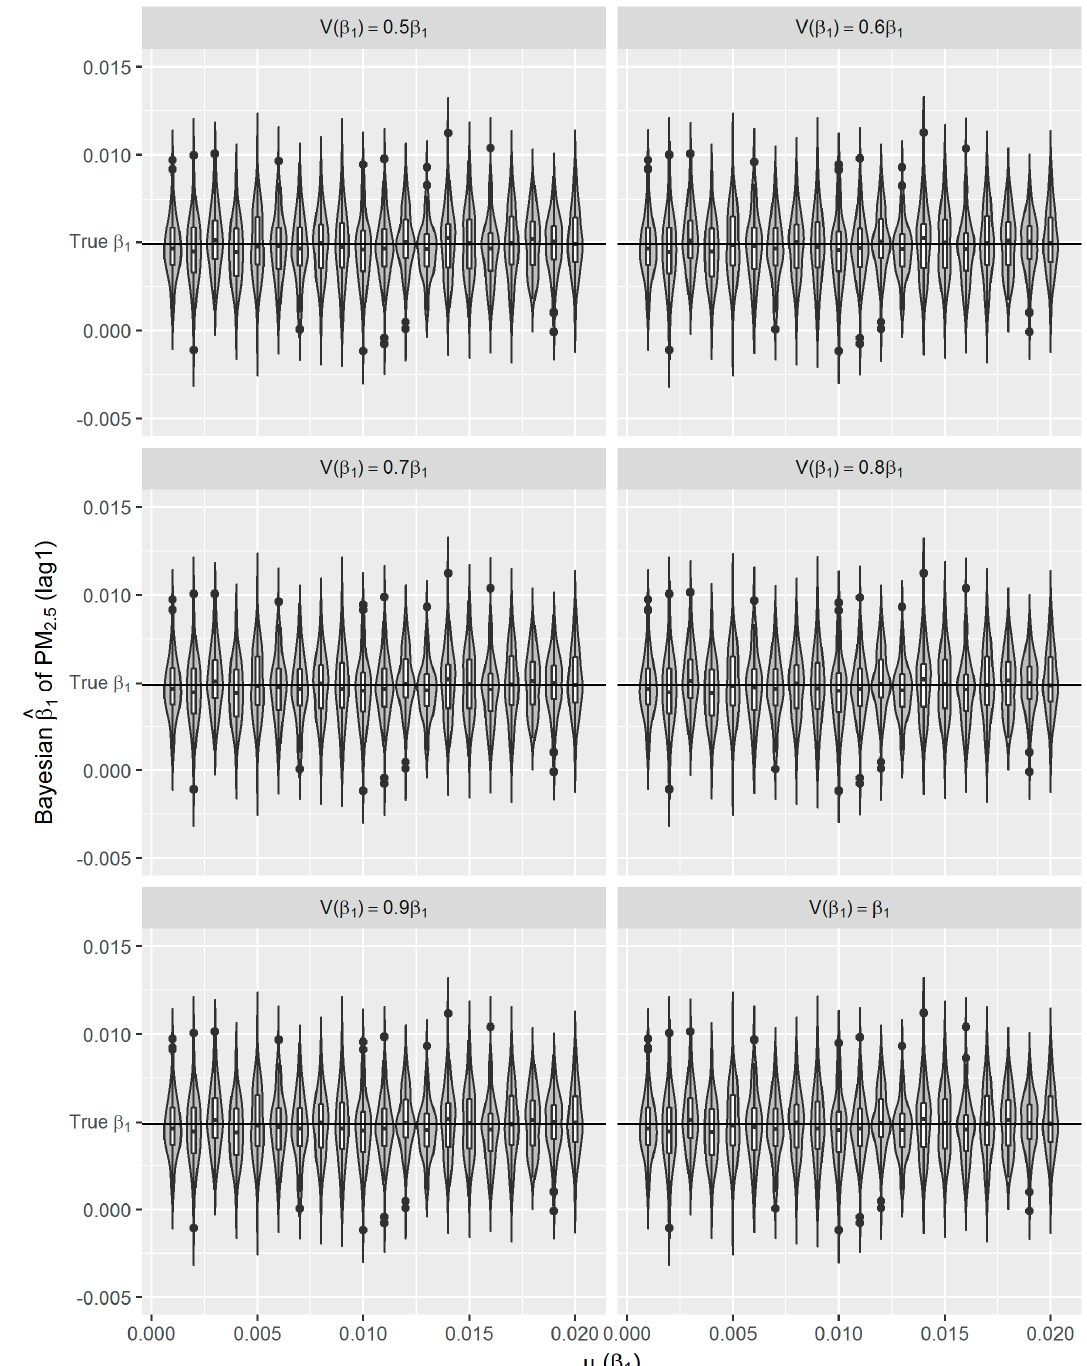
Figure 7. Distributions of Bayesian (cid:98) β 1 s from simulated data with σ = 0.5 (cid:98) σ , the true β 1 = 0.0049; in Bayesian GAM analyses df = 8 for S ( t ), V( β 1 ) equal to γβ 1 , where γ = 0.5, 0.6, . . . , 1.0, and µ ( β 1 ) ranging from 0.001 to 0.020 by 0.001 Table 5. Mean (SD) of estimated 𝛽(cid:4632) (cid:2869) s derived from Bayesian GAMs with different priors